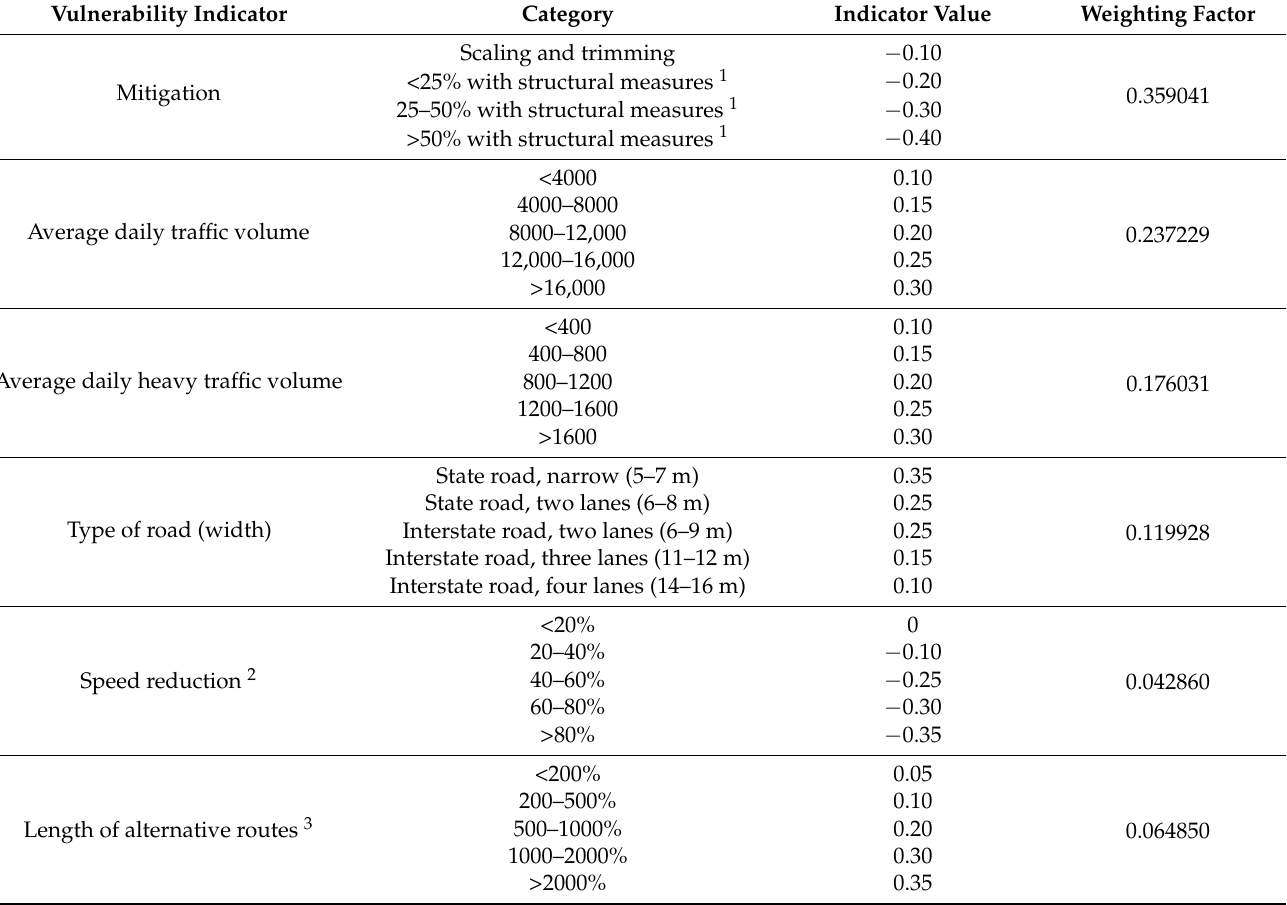
Table 3. Vulnerability indicators that were used for the vulnerability assessment and corresponding categories. The weighting factors were calculated with the analytical hierarchy